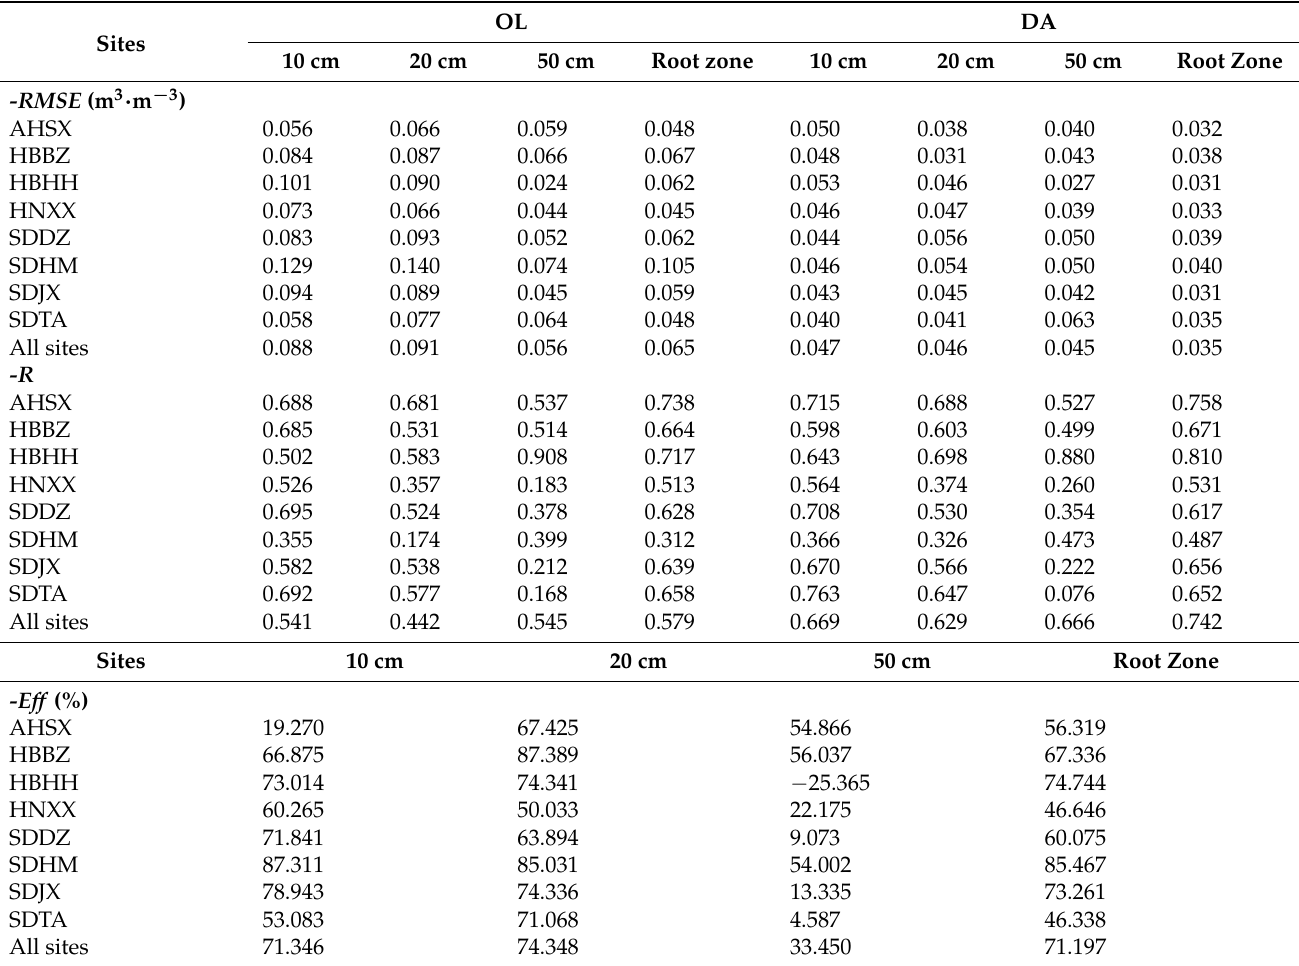
Table 3. Statistics of open-loop (OL) and assimilated (DA) soil moisture at all eight